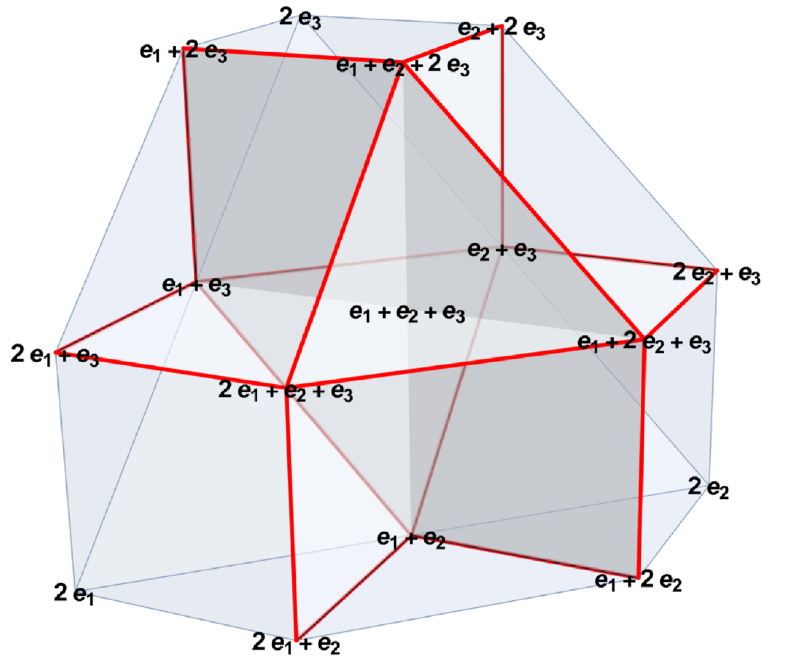
Figure 12 . Image of any ∆ 2 ,n under a generic projection x 7→ ( x i + · · · + x j , x j + · · · + x k , x k + · · · + x i ) into R 3 . Vertices of ∆ 2 ,n map to the 16 lattice points, which in turn correspond exactly to the 16 connected components of figure 11. The three lattice points e 1 + e 2 , e 2 + e 3 , e 1 + e 3 correspond (via the projection) to the sets of Mandelstam invariants that are set to zero in split kinematics. For emphasis, one of the three hexagonal cross-sections is